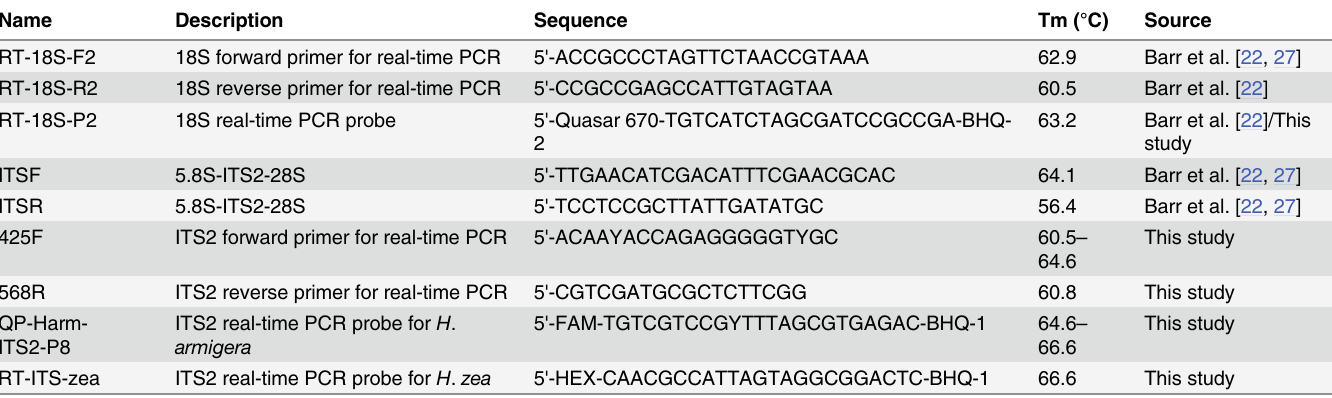
Table 2. Primers and probes used in this study (Tm = melting temperature in